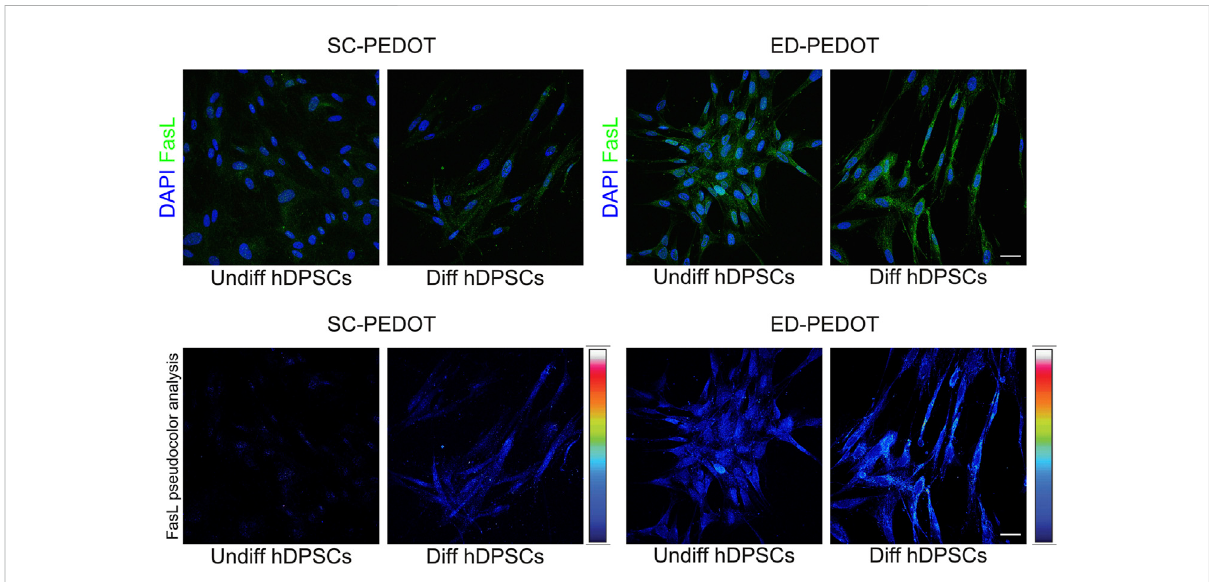
FIGURE 7 Evaluation of FasL expression in hDPSCs after culture on PEDOT: PSS fi lms. Immuno fl uorescence (top) and pseudocolour (bottom) analysis of FasL immunolabeling is shown in hDPSCs after 7 days of culture in the neurogenic medium. Control group consisting in hDPSCs cultured for 7 days in standard expansion medium. Nuclei were counterstained with DAPI. Scale bar: 20 μ